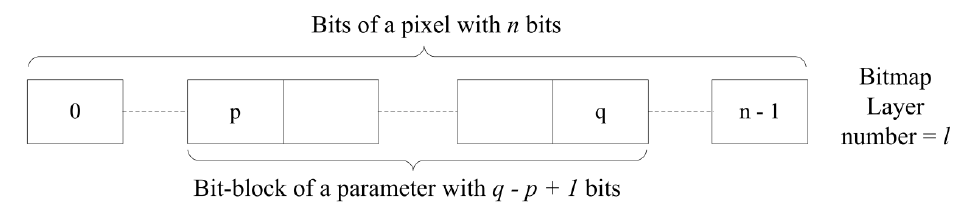
Figure 3. Four variables (V1, V2, V3 and V4) are represented using multiple bitmaps of a 32 ‐ bit RGB pixel format for forming a multi ‐ variable multi ‐ layer graphical knowledge unit (MVML ‐ GKU). Each pixel is divided into four equal portions, where each portion consists of eight bits. When the 32 ‐ bit RGB pixel format is divided into four equal parts, each variable represents the alpha, red, green and blue sections of the pixel. This provides a vertical array of k × L bits for one variable.